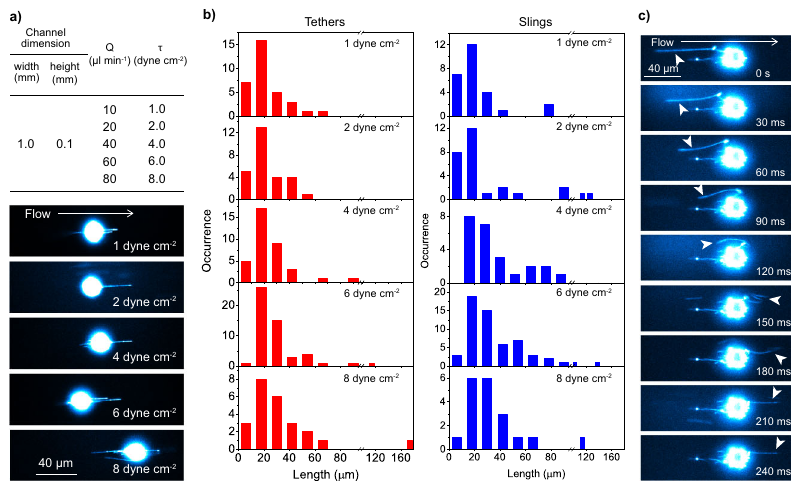
Fig. 3 Spatiotemporal dynamics of the tethers and slings during cell rolling. a Shear force-dependent formation of the tethers and slings on KG1a cells rolling over E-selectin. Fluorescence images of CD44 (immunostained by Alexa-Fluor-647-conjugated anti-CD44 antibody) captured during cell rolling over the surface-deposited E-selectin molecules. The cells were injected into the chambers at a shear stress of 1, 2, 4 or 8 dyne cm − 2 (0.1, 0.2, 0.4, and 0.8 Pa). The dimensions of the fl uidic chamber, volumetric fl ow rates ( τ ), and corresponding shear stress (Q) are inserted in the top. b Length of the tethers and slings formed on KG1a cells rolling over E-selectin. Frequency histograms of the length of tethers (red bars) and slings (blue bars) formed during the KG1a cells rolling over E-selectin. c Time-lapse fl uorescence images of CD44 (immunostained by Alexa-Fluor-647-conjugated anti-CD44 antibody) captured during cell rolling over E-selectin. The arrow heads show a tether that is converted into a sling upon the detachment of the tethering point from the E-selectin surface. The cells were injected into the chambers at a shear stress of 6 dyne cm − 2 (0.6 Pa). All the fl uorescence images of the rolling cells were captured by injecting KG1a cells into the rh E-selectin-deposited micro fl uidic on the tethers and slings were captured at the single-molecule level by either 2D (Fig. 2e, f) or 3D epi-illumination wide- fi eld fl uorescence microscopy (Fig. 2c, d) similar to the visualization of the tethers and slings.